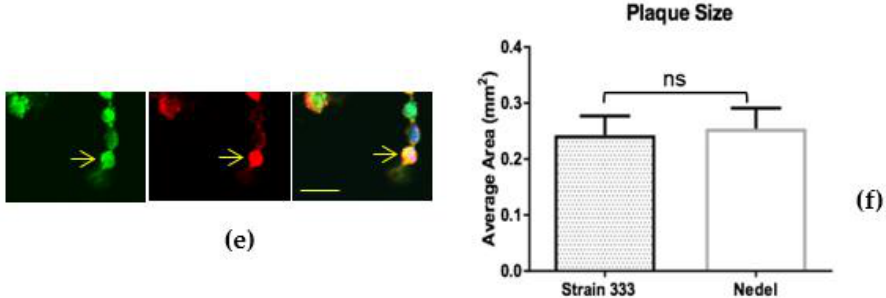
Figure 2. In Nedel-infected cells, mNeonGreen co-localizes with HSV antigen, and Nedel plaques are similar to wild-type. ( a ) Representative confocal image of a Nedel plaque on Vero cells. Nuclei ( upper left ) are stained with DAPI, mNeonGreen is detected ( upper right ) by fluorescence, and HSV-2 antigens are detected by immunofluorescent staining using a polyclonal HSV-2 antibody ( lower left ). Merged image is shown at lower right . Red bar = 100 µm. Enlarged images taken from the plaque shown in panel ( a ) illustrate fluorescence in the ( b ) nucleus, ( c ) cytoplasm, ( d ) and cell membrane, in some cases ( e ) obscuring the entire cell. Yellow arrow indicates location referenced in text; yellow bar = 15 µm. ( f ) Plaque size comparison, mean of 20 plaques, Error bars reflect SEM, Unpaired two-tailed t test p = 0.82.